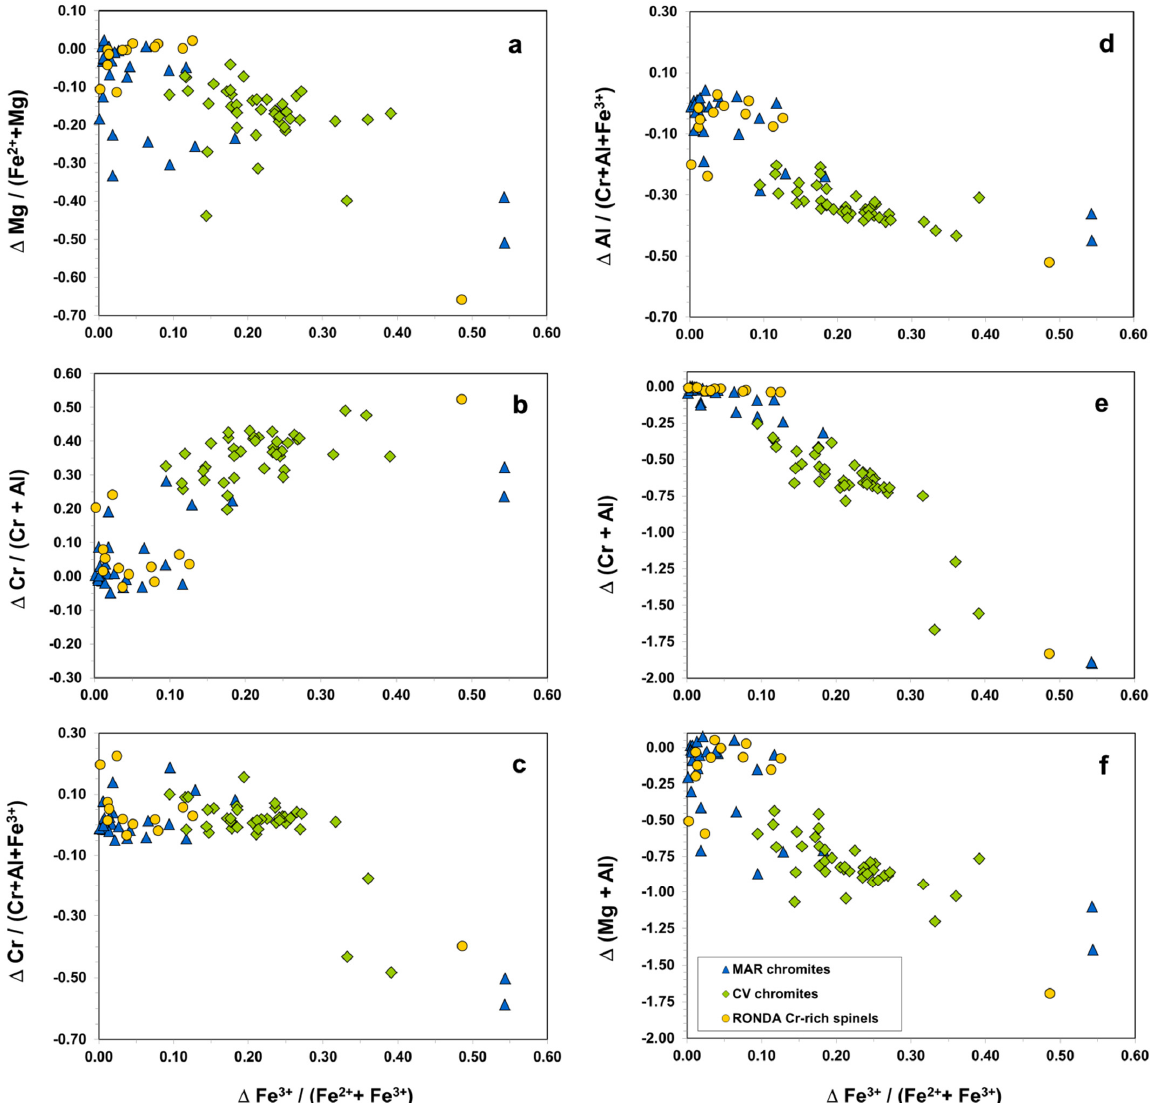
Figure 9. Variation of ( a ) Mg/(Fe 2+ + Mg), ( b ) Cr/(Cr + Al), ( c ) Cr/(Cr + Al + Fe 3+ ), ( d ) Al/(Cr + Al + Fe 3+ ), ( e ) (Cr + Al) and ( f ) (Mg + Al) with increasing Fe oxidation rates in the MAR magnesiochromite, CV chromites and Ronda chromian spinels.